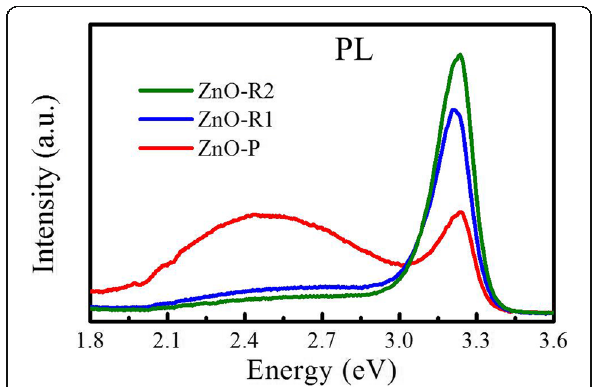
Fig. 4 PL results. Room-temperature PL spectra of the ZnO films with particle- or ridge-like